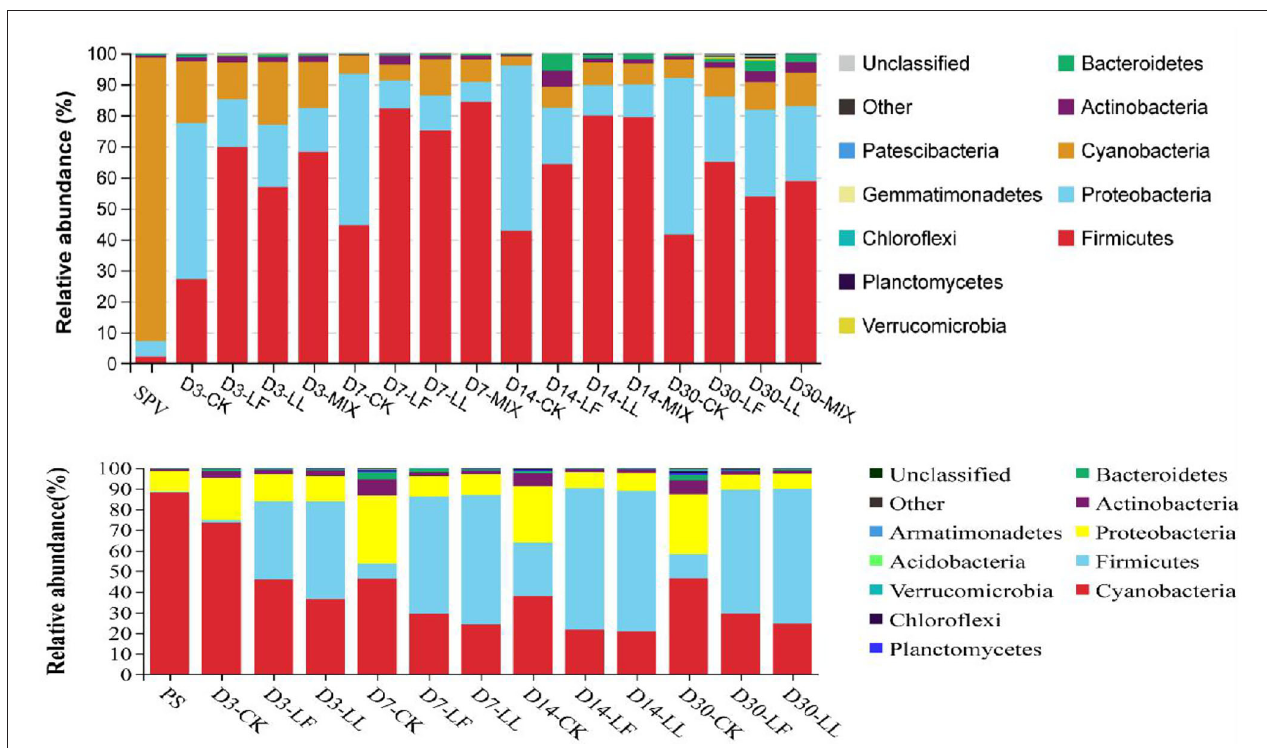
FIGURE 2 | Relative abundance of the bacterial community on phylum level of inoculated or non-inoculated SPV and PS silage. SPV, sweet potato vine; PS, peanut straw; CK, non-inoculated silage (Control); LL, silage inoculated with Lactococcus lactis (LL); LF, silage inoculated with Lactobacillus farciminis (LF); MIX, silage inoculated with the mixture (1:1) of LL and